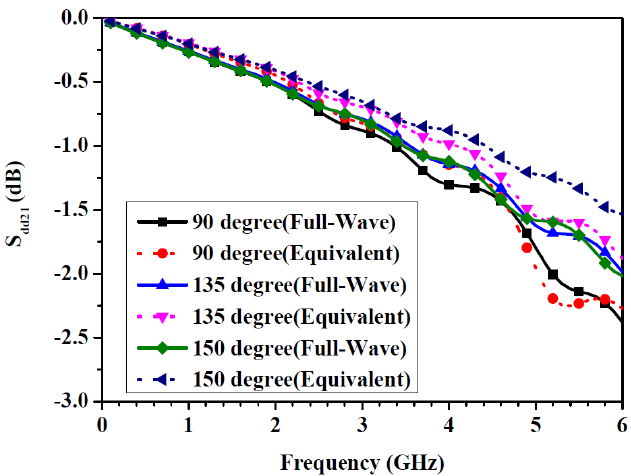
Figure 8. Sdd21 simulated results for the full-wave and equivalent circuit models.